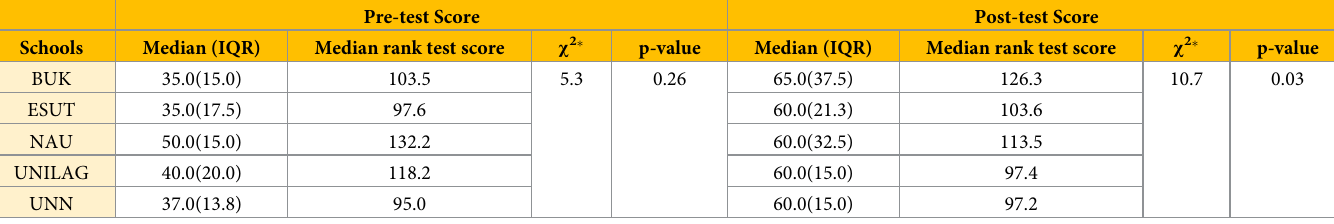
Table 4. Kruskal-Wallis test to compare pre- and post-test scores among